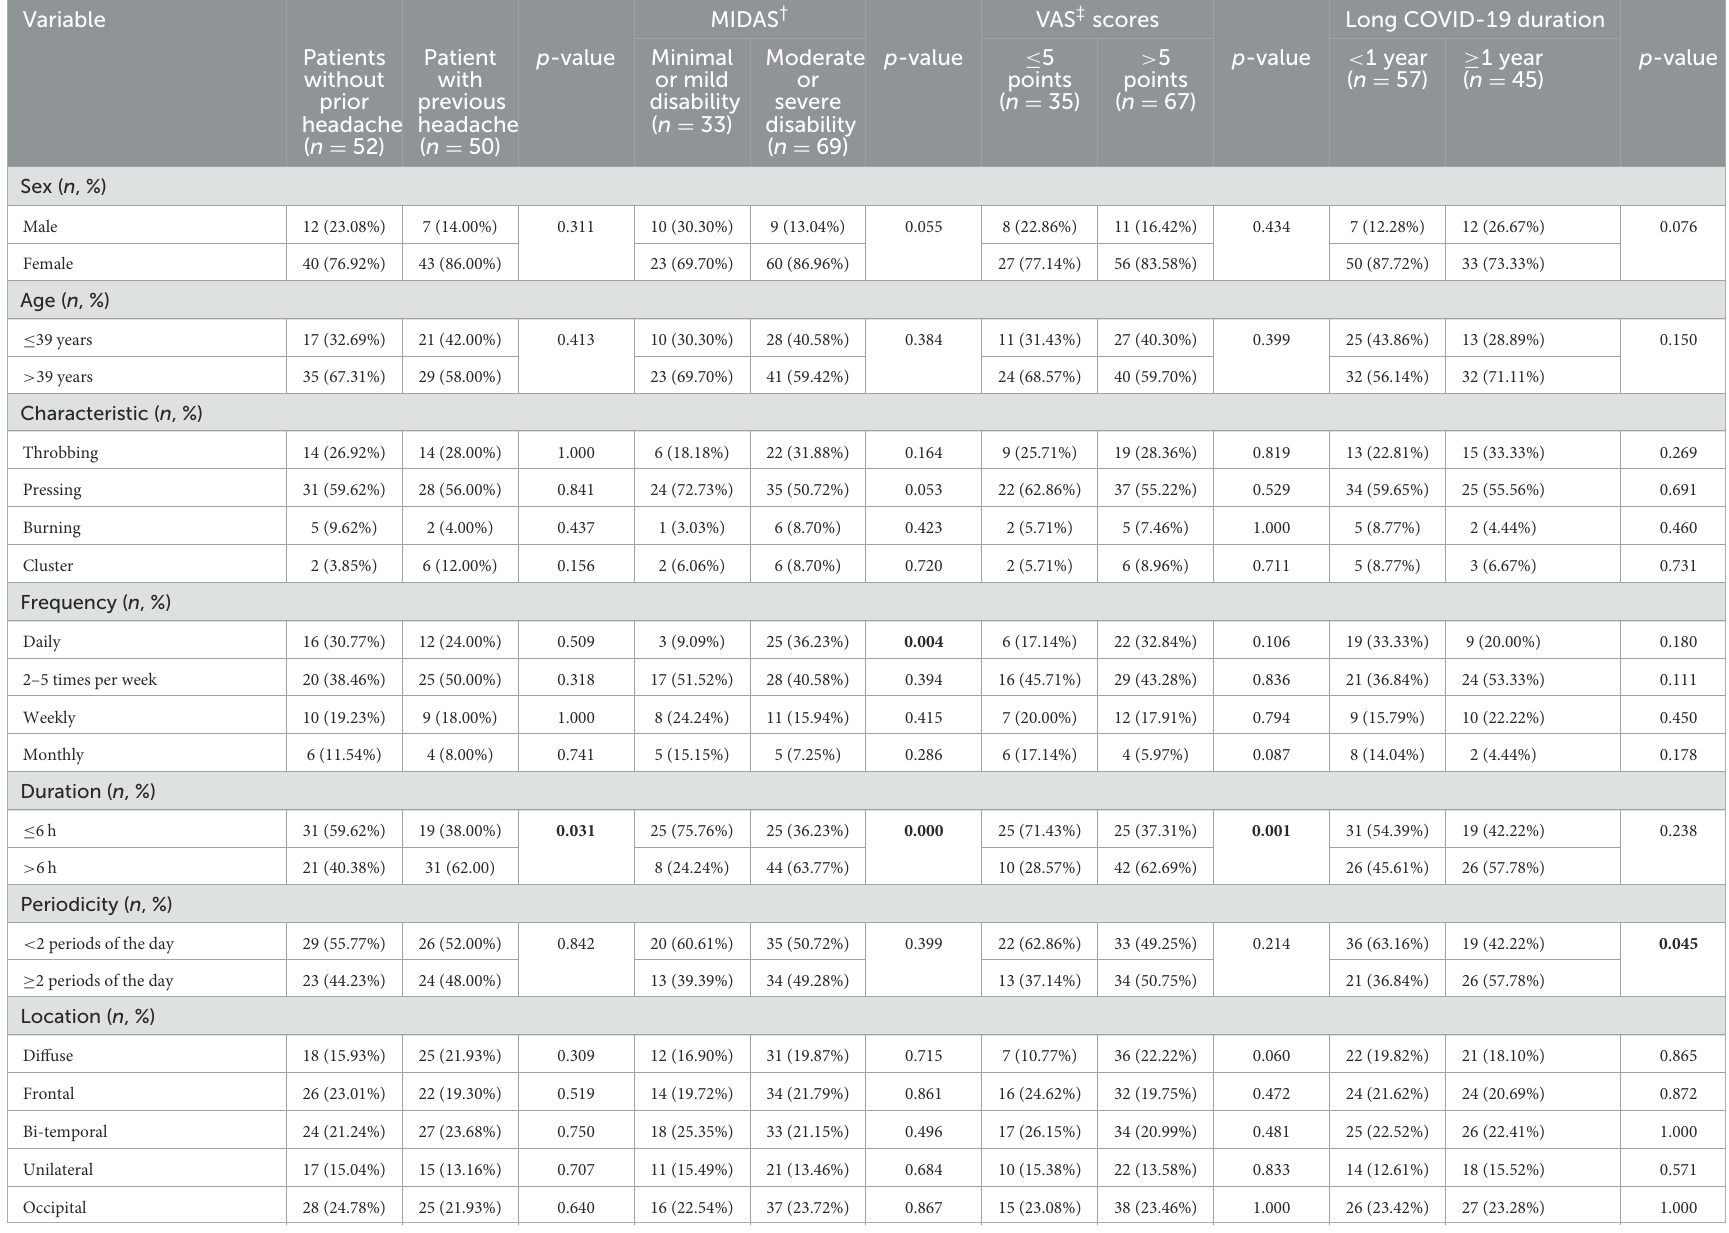
TABLE 3 Characteristics of patients with headache and long COVID-19 stratified by MIDAS † grades, long COVID-19 durations, and VAS ‡